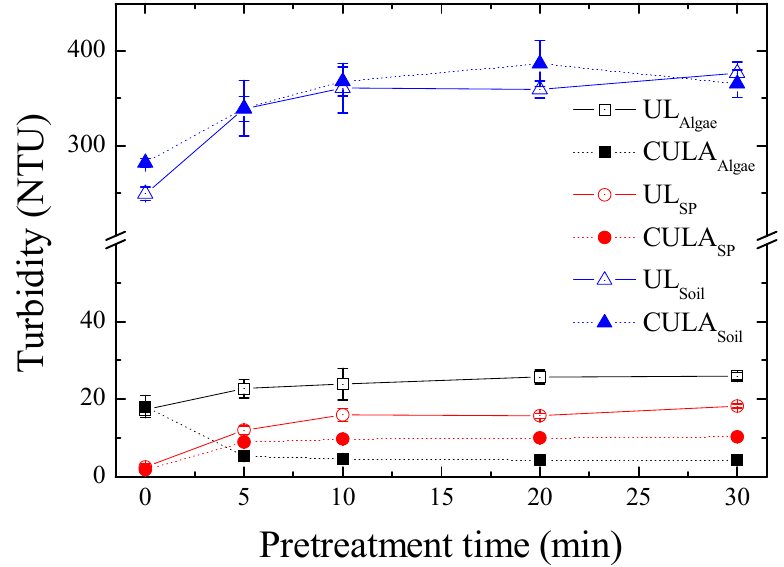
Figure 2. Changes in turbidity (NTU) of water samples containing suspended solids from different origins (algae, sewage particles (SP), and soil) for pretreatment time (min).